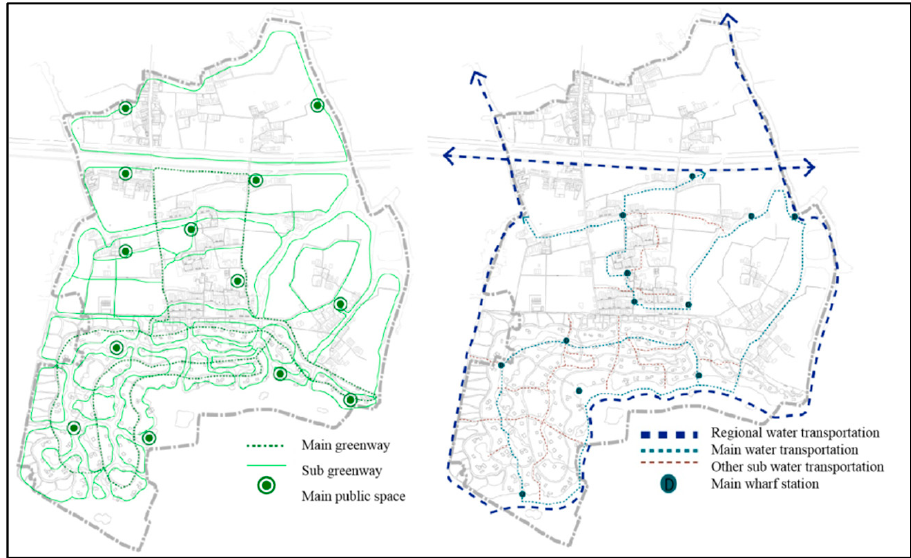
Figure 5. Plans of green-way and blue-way systems in Heshu village.